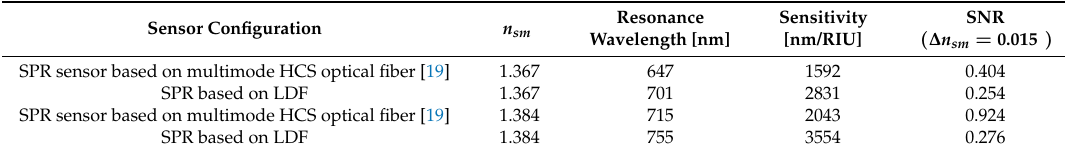
Table 1. Comparison of performance of two different SPR multimode optical fiber sensors for two refractive indices (1.367 and 1.384).